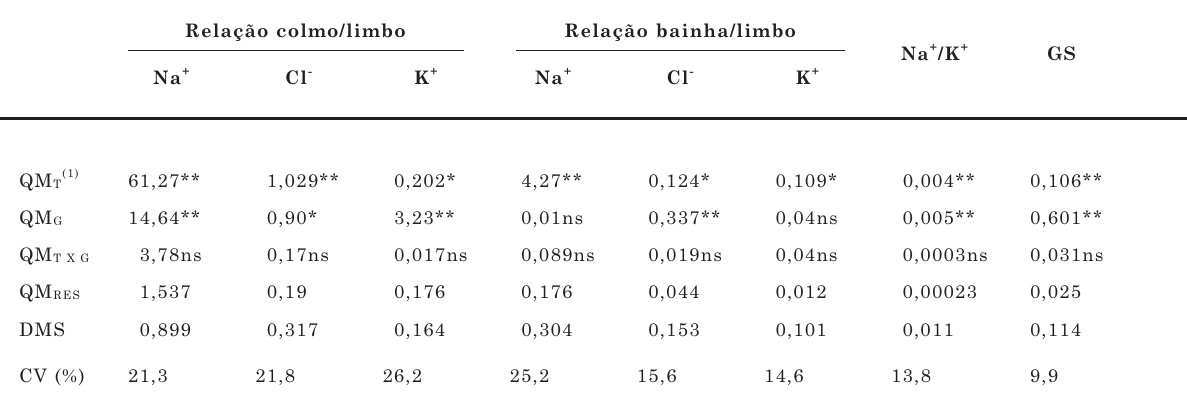
Quadro 5. Valores dos quadrados médios e significância estatística para as relações entre os teores de Na + , Cl - e K + no colmo e bainha em relação aos respectivos teores desses íons no limbo foliar, relação Na + /K + no limbo foliar e grau de suculência foliar (GS), em plantas de dois genótipos de sorgo forrageiro irrigadas com águas salinas com diferentes condutividades elétricas (CEa)